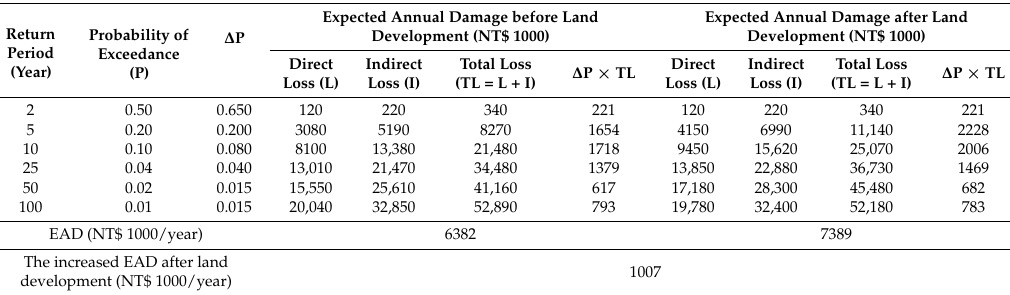
Table 5. Flooded area and the average flooding depths of various return periods before and after land